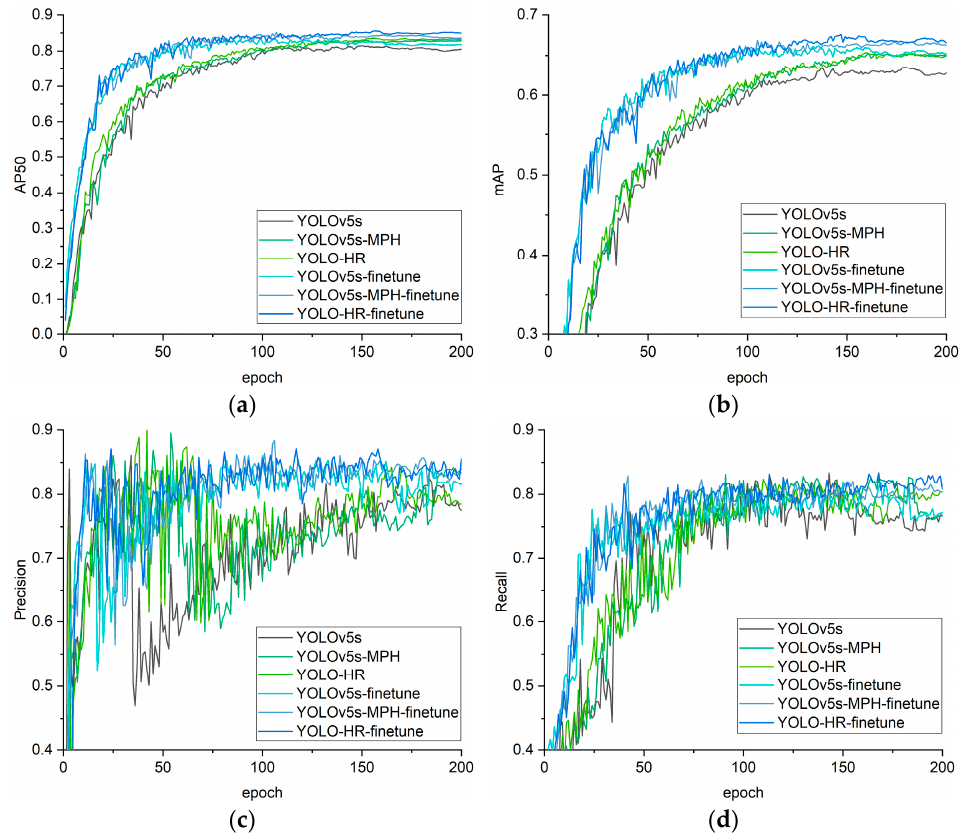
Figure 6. Results comparison chart. ( a ) AP50, ( b ) mAP, ( c ) Precision, ( d ), Recall. Table 4. Performance improvement of each part design on the result.